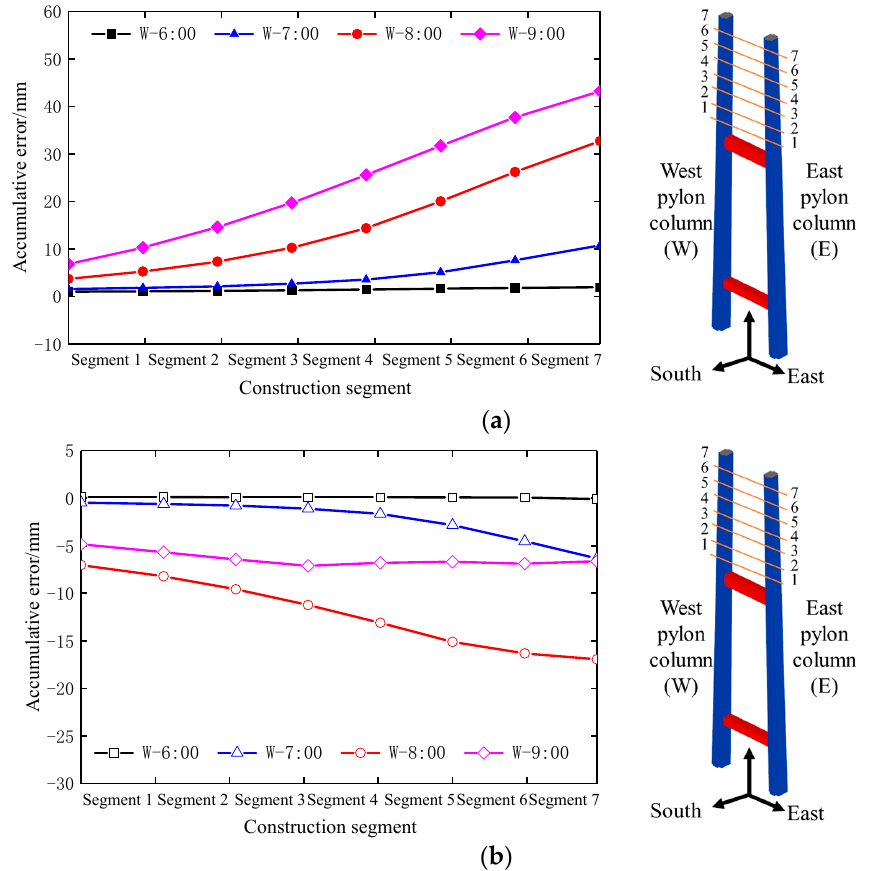
Figure 21. In fl uence of shadow occlusion on alignment shape of bridge pylon during summer con- Figure 21. Influence of shadow occlusion on alignment shape of bridge pylon during summer struction: ( a ) Transverse alignment shape. ( b ) Longitudinal alignment shape. construction: ( a ) Transverse alignment shape. ( b ) Longitudinal alignment